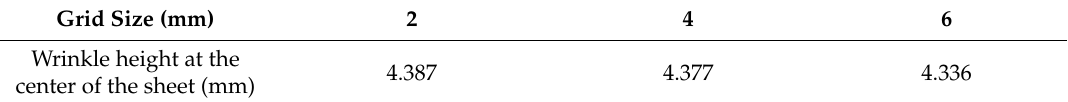
Table 2. Comparison of calculation results for di ff erent grid sizes with the S8R element.